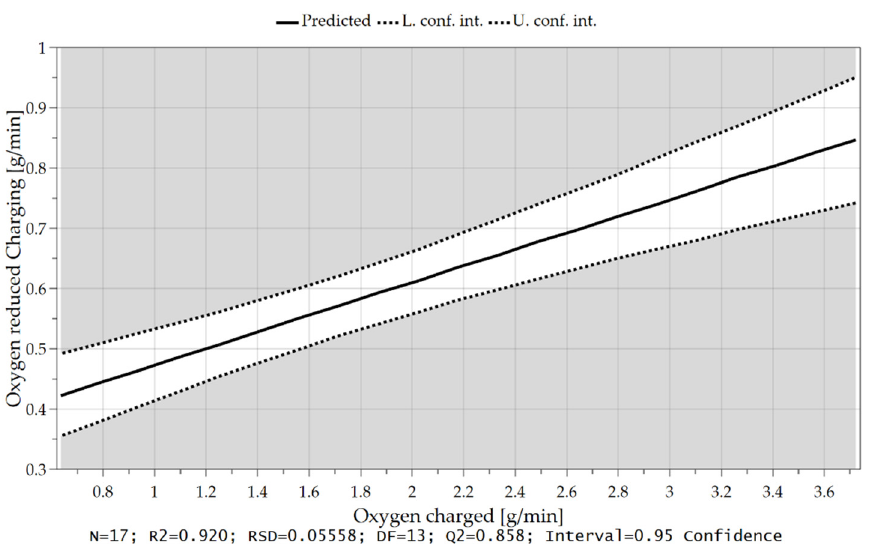
Figure 20. Oxygen removal rate as a function of the introduced oxygen via iron ore feeding.